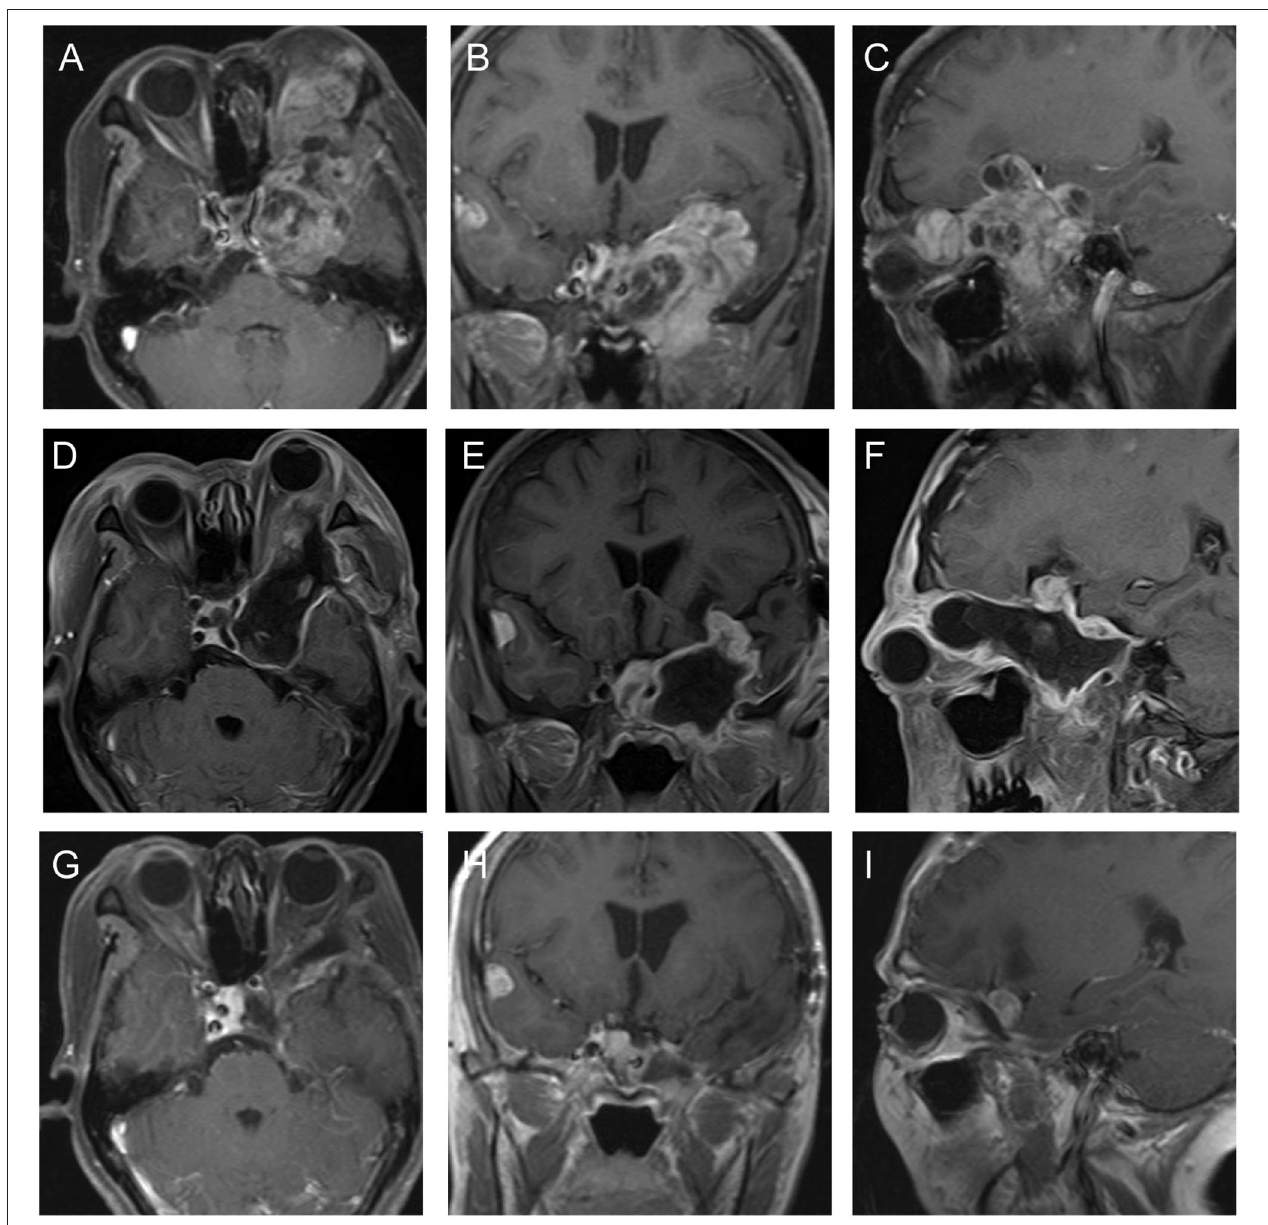
FIGURE 5 | The preoperative, postoperative, and follow-up MRI imaging of case 5. (A–C) Preoperative MRI showed the trigeminal schwannoma involved the left middle fossa, orbit, and infratemporal fossa. (D–F) Postoperative MRI showed the most of the tumor was completely removed. We considered the postoperative dura enhancement was due to the scarring formation from the primary surgery. (G–I) Follow-up MRI showed no